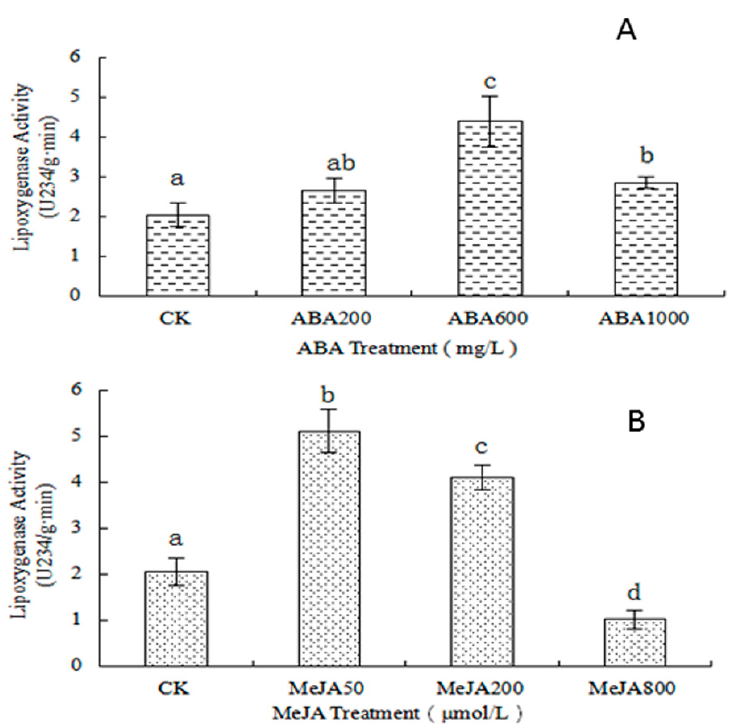
Figure 2. Lipoxygenase activity of Cabernet Sauvignon berries after different treatments. ( A ) ABA treatment; ( B ) MeJA treatment. Experiments were repeated three times. Data are the mean ± SD of replicates. ABA1000: treatment with 1000 mg · L − 1 ABA; ABA600: treatment with 600 mg · L − 1 ABA; ABA200: treatment with 200 mg · L − 1 ABA; MeJA800: treatment with 800 µ mol · L − 1 MeJA; MeJA200: treatment with 200 µ mol · L − 1 MeJA; MeJA50: treatment with 50 µ mol · L − 1 MeJA; C: control. Different letters within a column indicate statistically significant differences between the means ( p < 0.05).